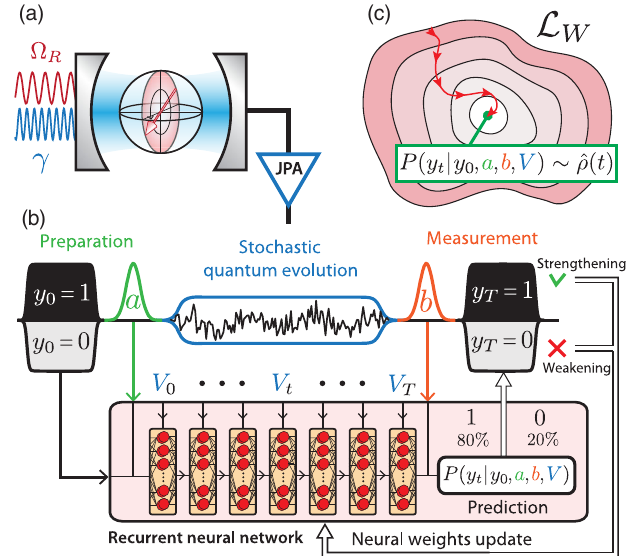
FIG. 1. Recurrent neural network training from physical ob- servations. (a) Schematic of the superconducting qubit disper- sively coupled to a microwave cavity monitored by a high quantum efficiency Josephson parametric amplifier (JPA). The qubit is simultaneously driven on resonance at a Rabi rate Ω R and dispersively monitored with a strength γ ϕ near the cavity resonance frequency. (b) Data collected from the experimental system, comprising the preparation, measurement outcomes, and continuous measurement record of the qubit, are directly streamed to a RNN, which provides a prediction of the meas- urement outcome. The weights of the RNN are updated at each iteration through stochastic gradient descent. (c) The stochastic gradient descent aims at minimizing the cross-entropy loss function L W , which evaluates the distance between the prediction and the measurement ⃗ h ϕ ð W : ⃗ h nonlinear activation function ϕ such that t ¼ h t − 1 þ ⃗ B ⃗ W V W and B are the weights of the t V þ h Þ , where